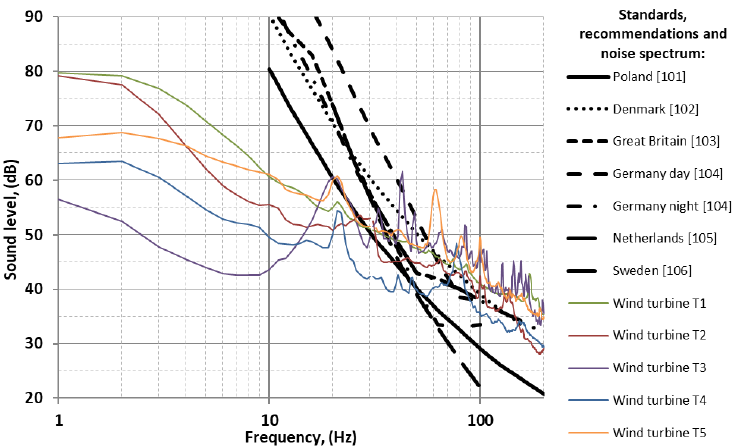
Figure 22. Comparison of amplitude spectra of investigated wind turbines from various countries. Results of study based on details in [28].